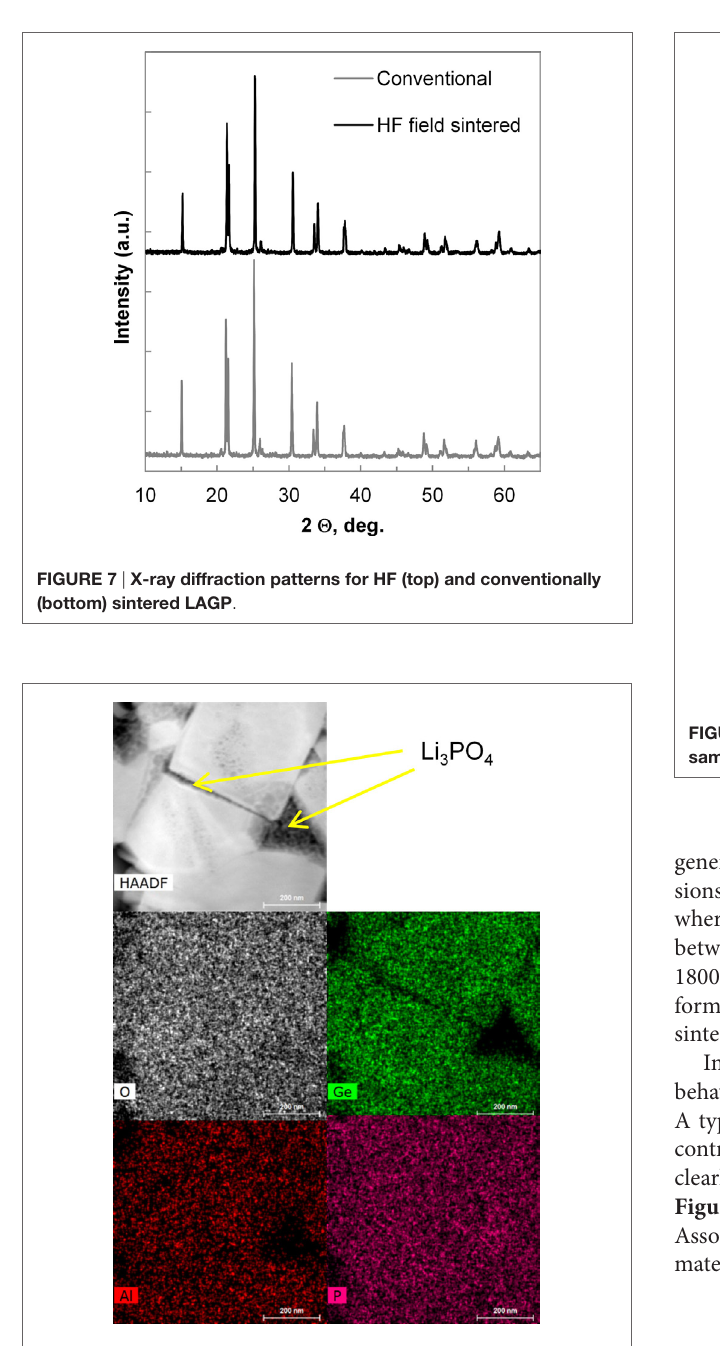
FigUre 8 | hrTeM, eDs elemental maps, field-assisted sintered sample